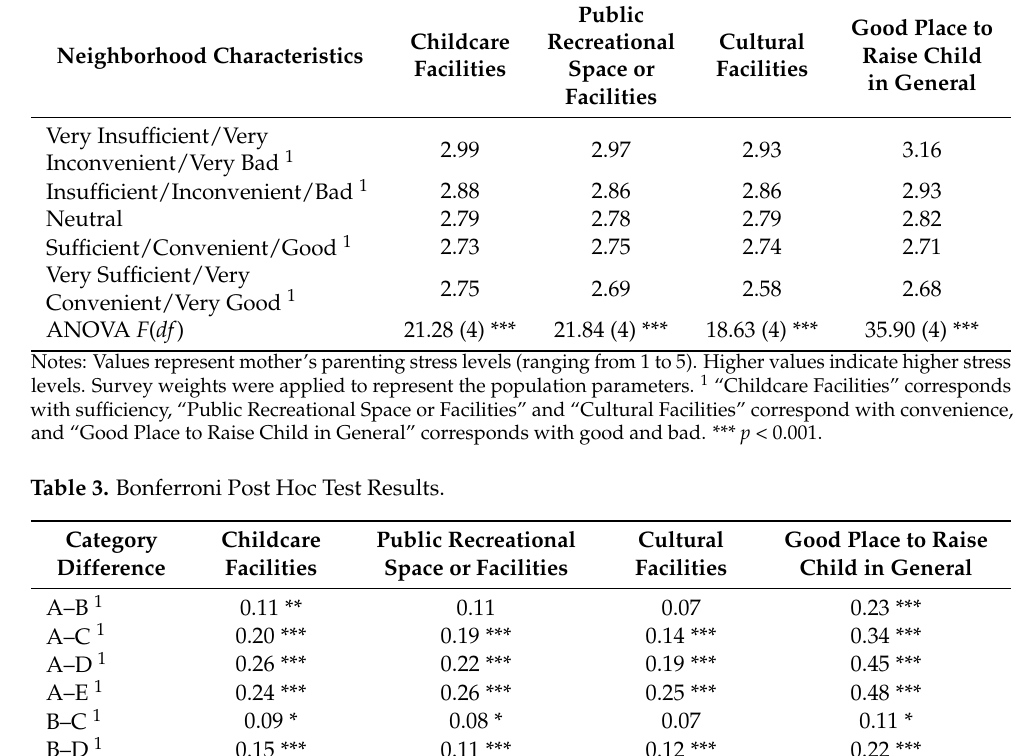
Table 2. Mean Mothers’ Parenting Stress by Neighborhood Characteristics ( n = 1536).